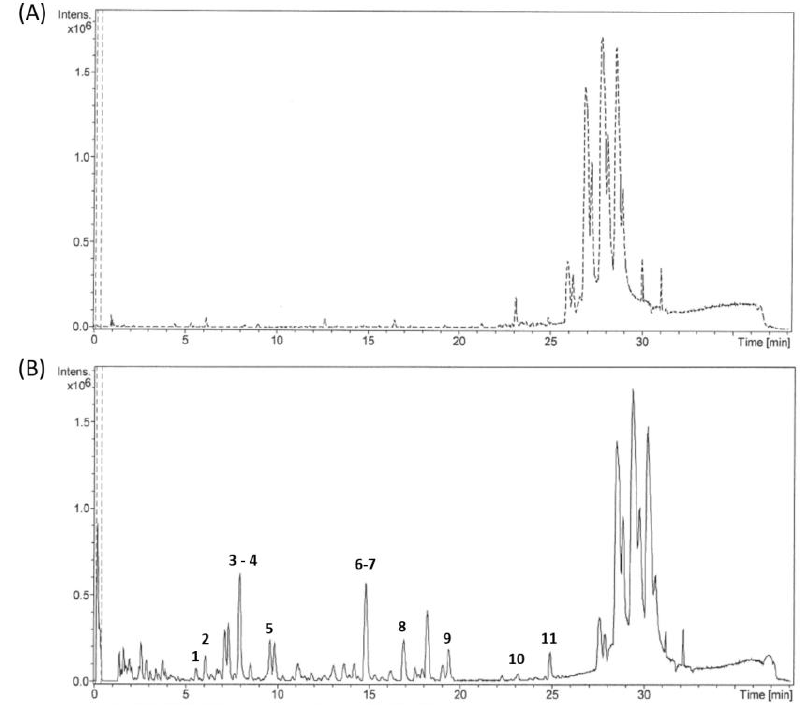
Figure 1. Liquid chromatography/Mass spectrometry LC/MS chromatogram for rats’ urine samples: ( A ) Control untreated rat and ( B ) PC 5 mg/kg/day treated rat after 14 months of treatment. The identified metabolites in chromatogram B are: 1. Tyrosol, 2. Pyrocatechol-sulfate, 3.